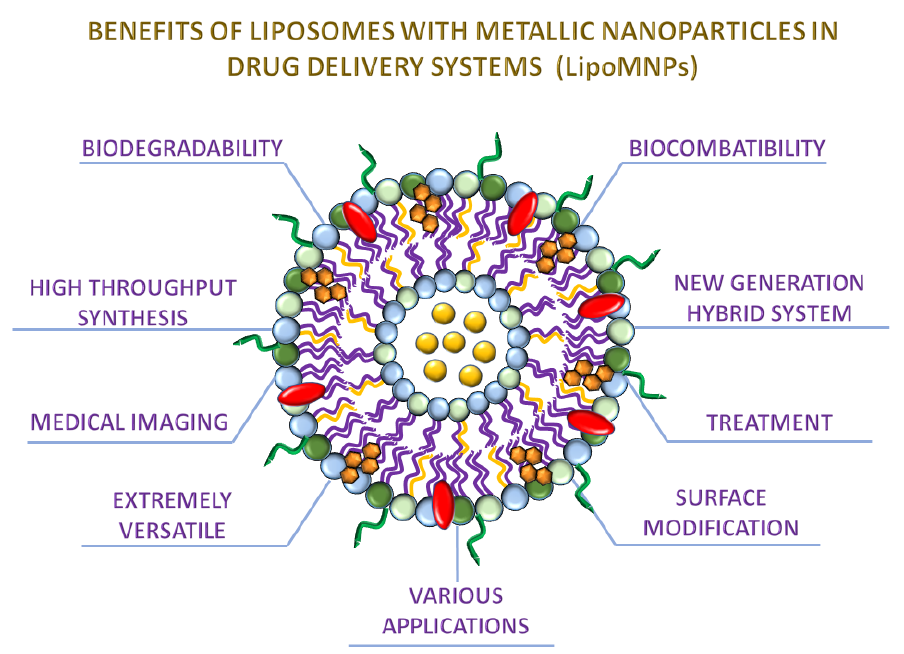
Figure 1. Benefits of liposomes with incorporated metallic nanoparticles in drug delivery systems. The picture presents the most interesting and crucial aspects of LipoMNPs according to usage in cancer treatment and medical imaging. The liposome of mixed lipid composition was selected as a simplified model. The Lipo-MNPs consist of phospholipids, cholesterol, DSPE-PEG, and MNPs.